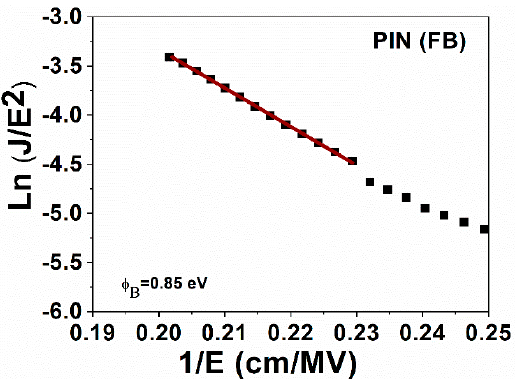
Figure 7. Ln (J/E 2 ) vs. 1/E of the device PIN.